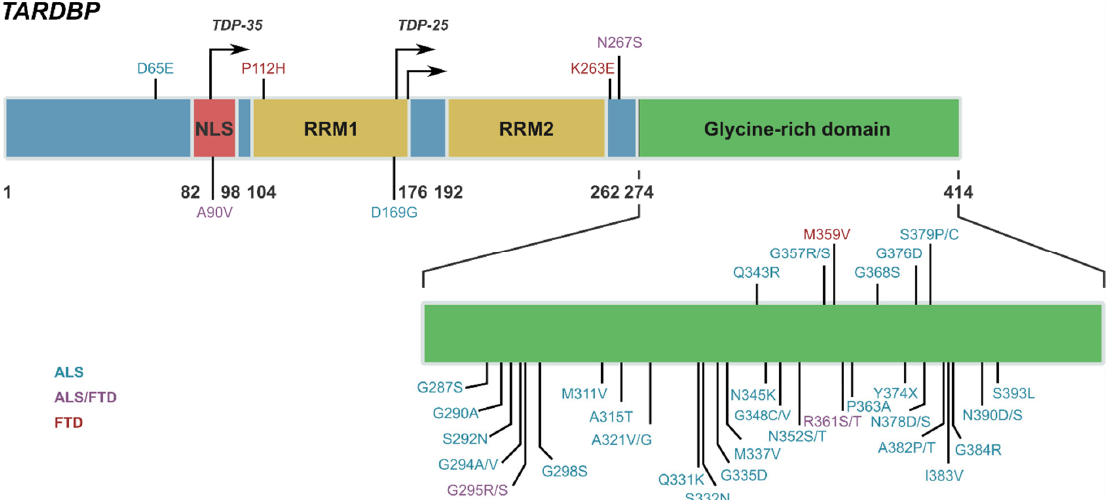
Figure 1. Structure of TDP-43. TDP-43 is a 43 kDa, 414 amino acid nuclear RNA/DNA-binding encoded by the TARDBP gene and part of the heterogeneous nuclear ribonucleoprotein (hnRNP) family. Structurally TDP-43 consists of an N-terminal and two DNA/RNA binding domains (RRM1 and RRM2) followed by a glycine rich C-terminal domain where TDP-43 mediates protein–protein interactions and where the majority of all pathogenic TARDBP mutations have been identified to date for both ALS and FTD. Predominantly localised to the nucleus owing to its nuclear localisation signal (NLS), TDP-43 shuttles between the nucleus and cytoplasm via nucleocytoplasmic transport, assisting with the regulation of many aspects of RNA processing including splicing, trafficking, stabilisation, and miRNA production. Structural, post-translational modifications to TDP-43 can occur during pathological conditions, causing abnormal mislocalisation and accumulation in the cytoplasm of neurons and proteolytic cleavage of TDP-43 into abnormal C-terminal fragments, TDP-35 and TDP-25. Alterations in the RRM1 of TDP-43 via oxidation can induce its aggregation and mislocalisation into the cytoplasm and misfolding of the RRM1 domain is thought to underlie TDP-43 misfolding, oligomerisation, accumulation, and ultimately proteinopathy. Both the NLS and RRM1 domain of TDP-43 are potential structural sites playing an important facilitatory role in the interaction of TDP-43 with central inflammatory pathways including NF- κβ